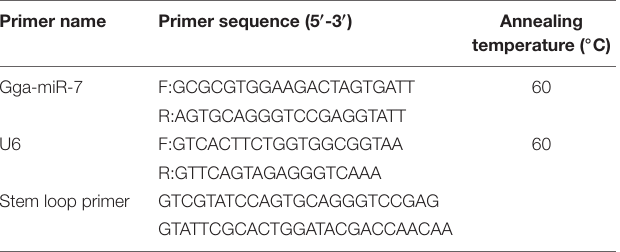
TABLE 1 | MiRNA primers used for